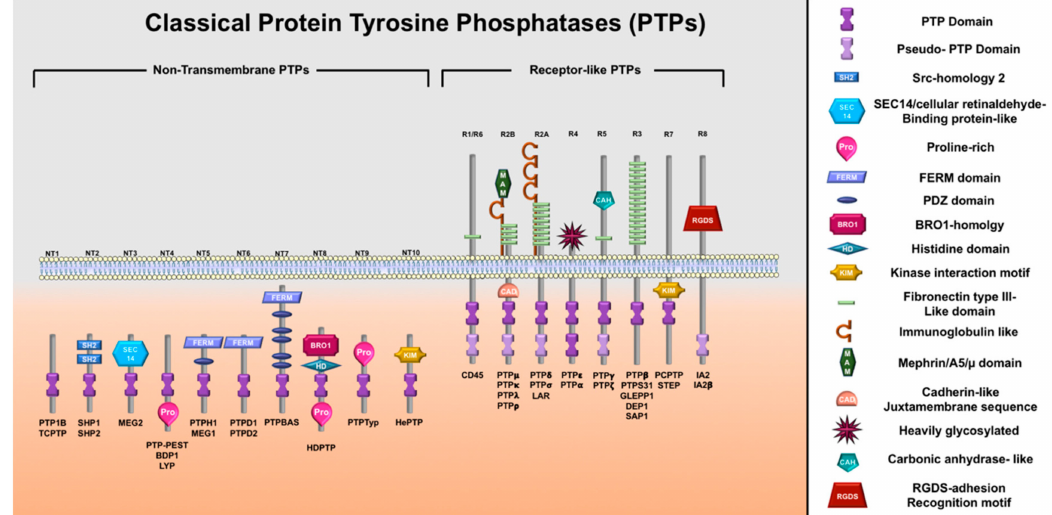
Figure 3. Classical PTPs. The classical PTPs are a large family of tyrosine phosphatases composed of 37 family members that are subdivided based on their cellular localization into 16 non-transmembrane (cytosolic) PTPs and 21 transmembrane receptor-like PTPs. The non-transmembrane phosphatases have one catalytic domain while receptor-like PTPs have either one or two catalytic domains, having the intrinsic catalytic cysteine